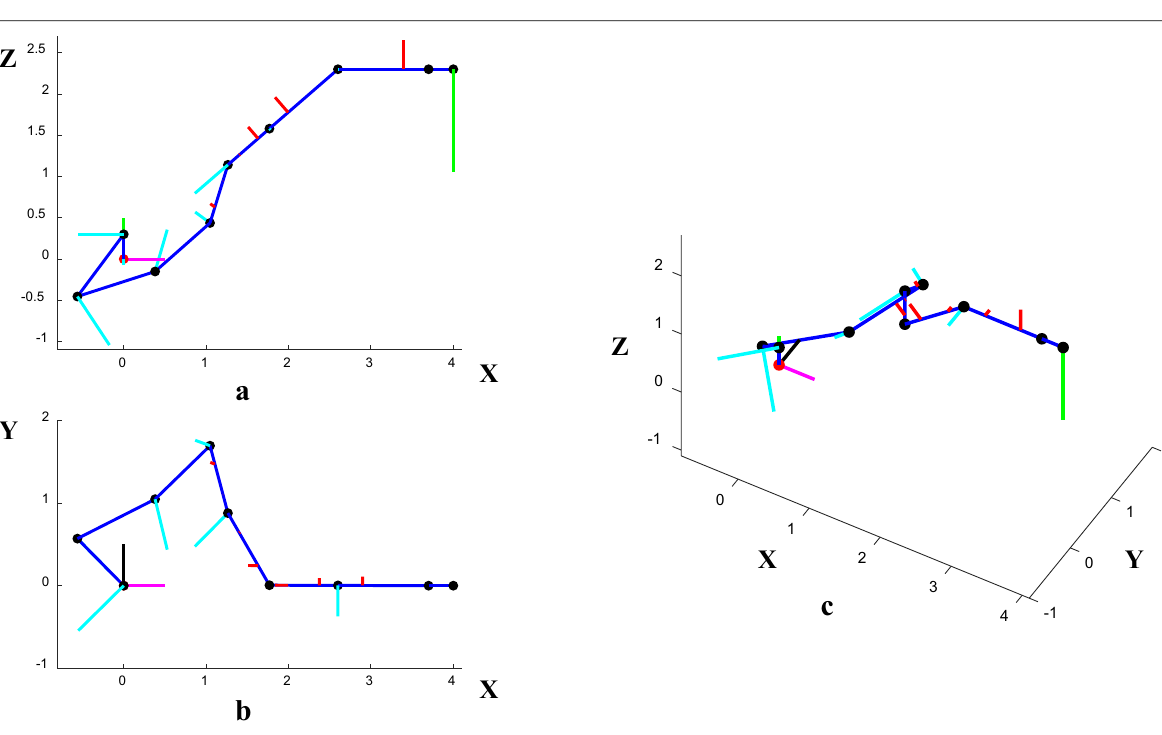
Fig. 13 The simulation arm and flying watch thrusts under the second level watch-actuator cooperation when the external reaction force on the end effector is [0,0, 125] N (reduction rate 20.8%). a Front view. b Top view. c 3-D − =